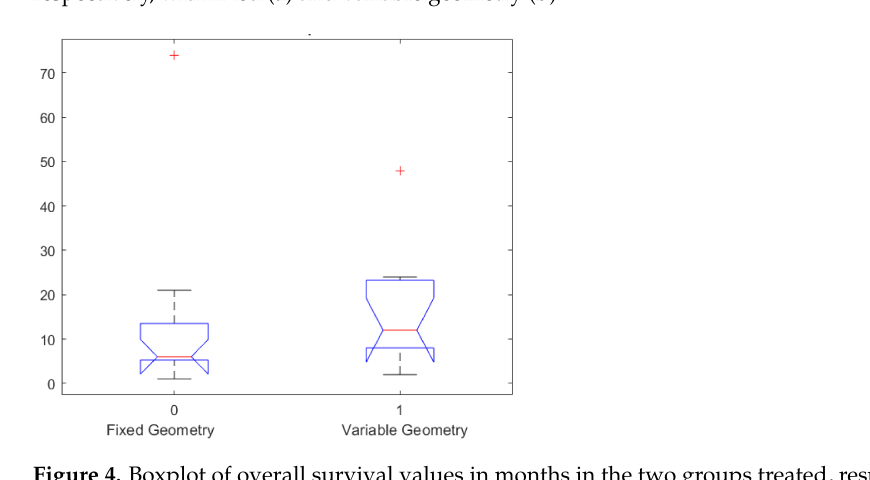
Figure 3. Overall survival curve (months) by Kaplan–Meier analysis in the two groups treated, respectively, with fixed ( a ) and variable geometry ( b ).